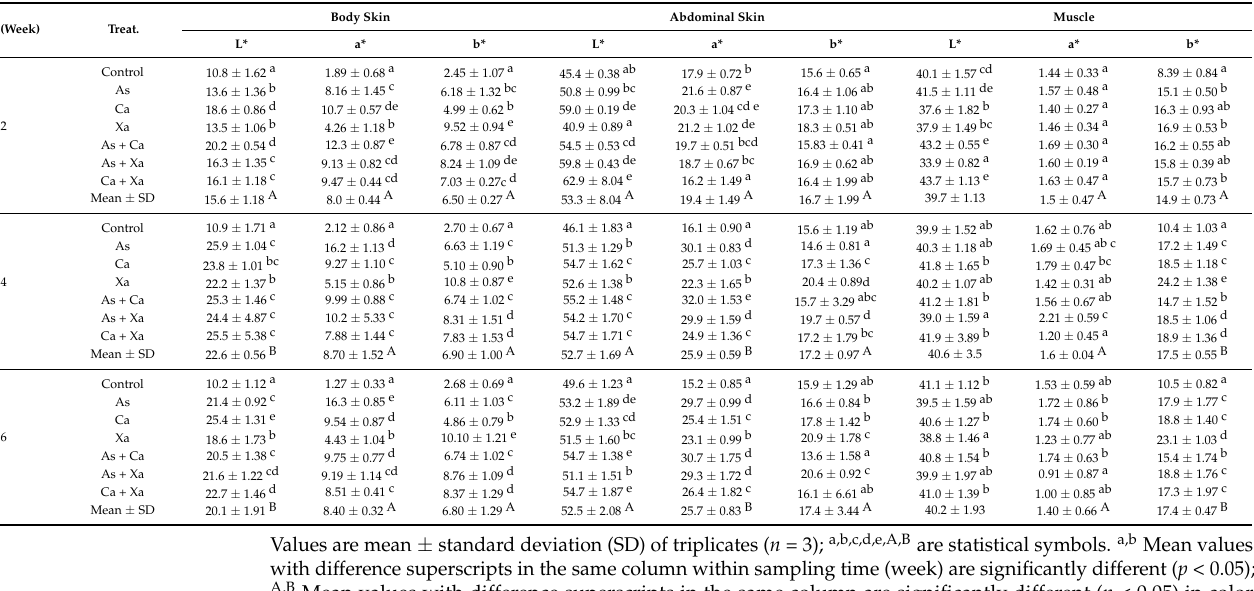
Table 3. L*, a*, b* for body skin, abdominal, and muscle of bighead catfish during the trial. Time(Week) Treat.